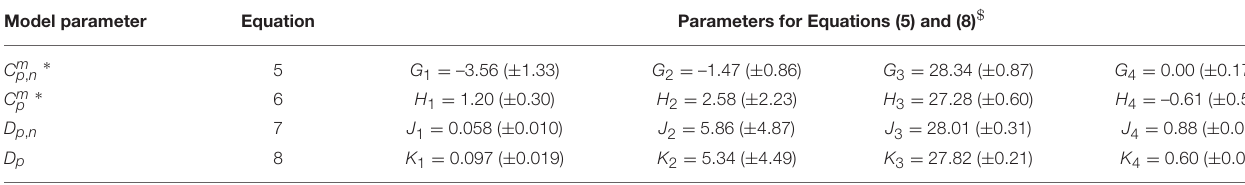
TABLE 5 | Parameter values for Equations (5)–(8). Model parameter